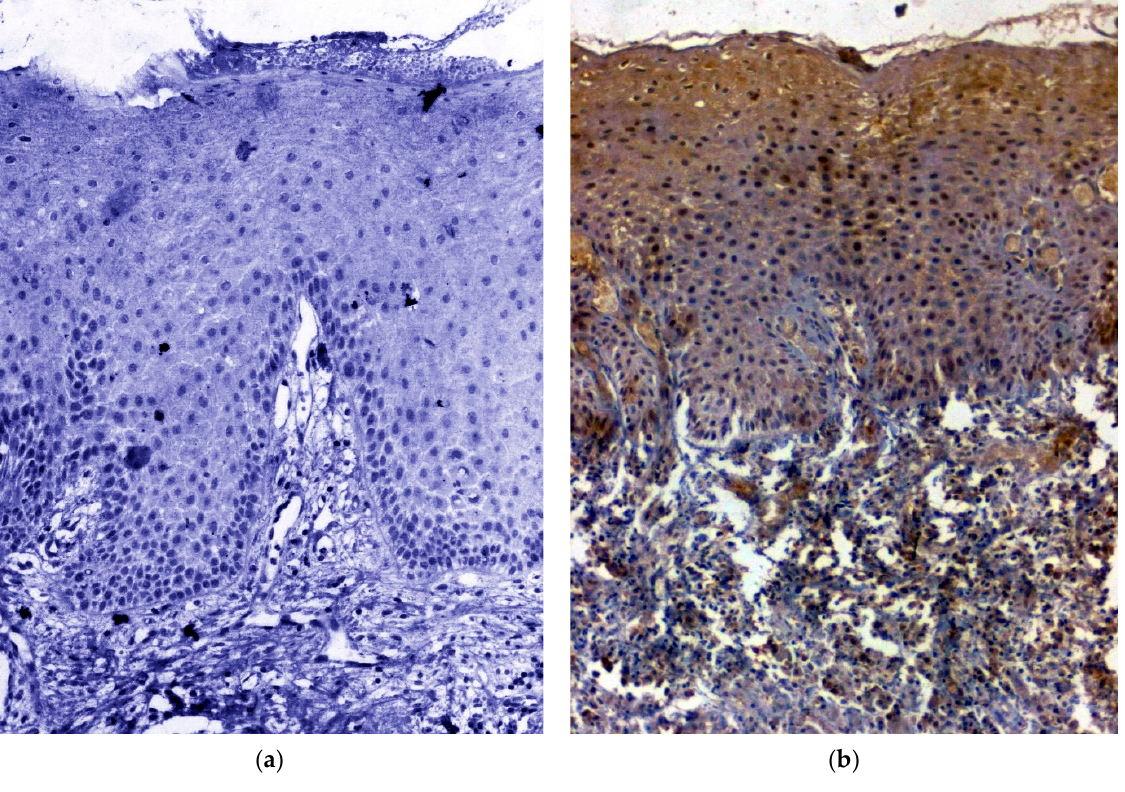
Table 2. Cont. Table 2. Clinicopathological features of OCT 3/4 expression in OSMF, OSCC and healthy controls.